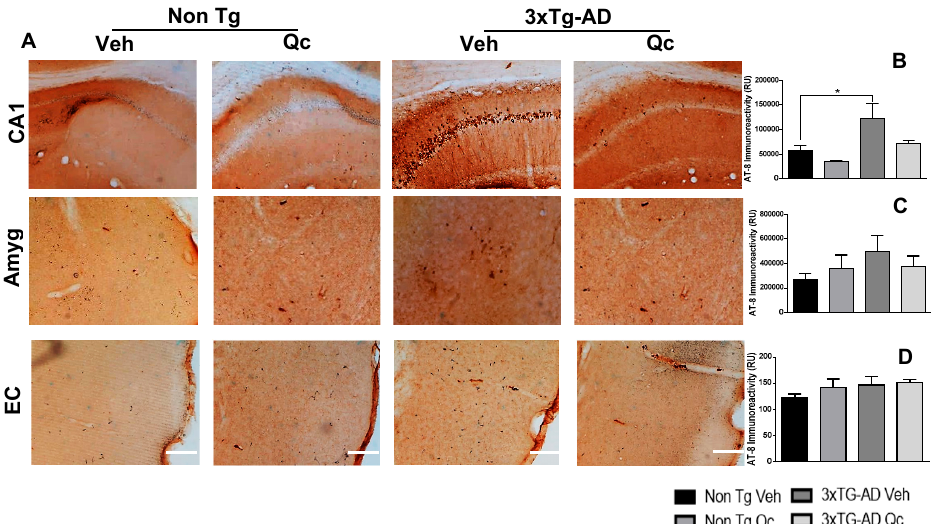
Figure 2. Quercetin oral administration effect on the prevention of hyperphosphorylation of tau. Representative images of the AT-8 immunoreactivity in the CA1 region of hippocampus, the amygdala and the entorhinal cortex of 3xTg-AD mice and non-Tg 19-month-old mice treated with vehicle and quercetin ( A ). Magnification: 10x. Scale bar: 50 μ m. The values in the immunoreactivity graphs are expressed in relative densitometric units (RU) in the CA1 of the hippocampus ( B ) Amyg: amygdala ( C ) and EC: entorhinal cortex ( D ). Veh: Vehicle (DMSO 0.5%), Qc: quercetin. n = 3. * p : < 0.05.